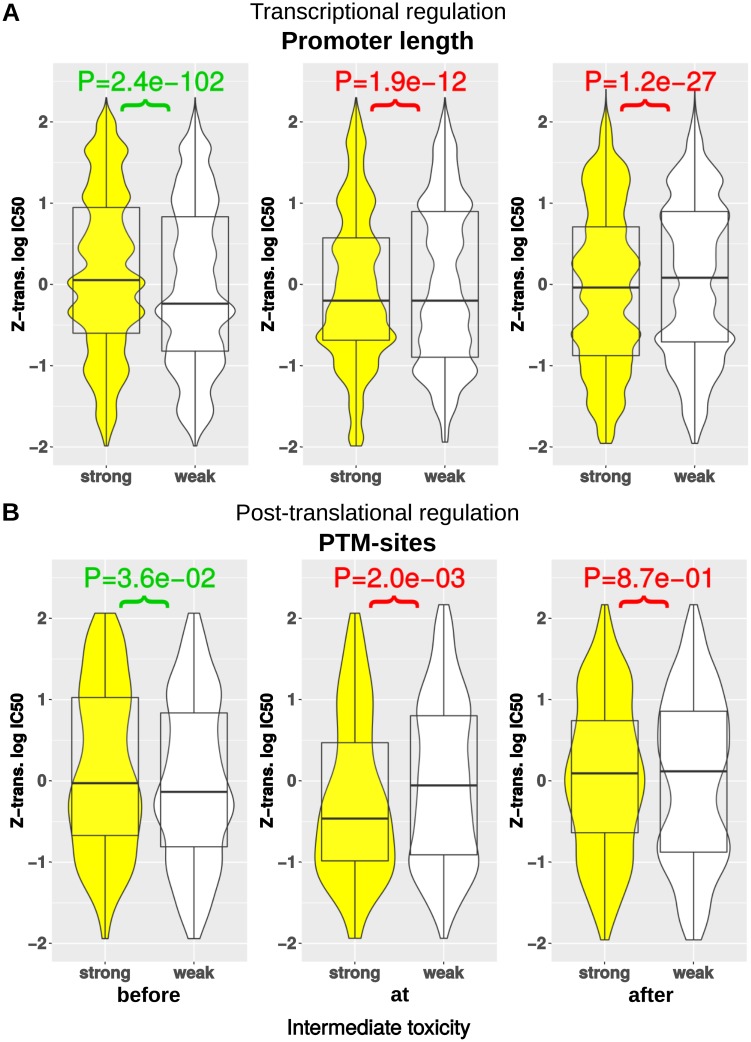
Comparisons of intermediate toxicity distributions before (left), at (middle) and after strongly regulated enzymes for (A) transcriptional regulation and (B) post-translational regulation.Yellow color indicates toxicity distributions for strongly regulated enzymes, and white color the corresponding toxicity distributions for direct downstream intermediates of weakly regulated enzymes (lower values indicate higher toxicity).